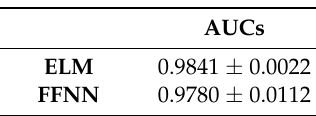
Figure 7. Receiver Operating Characteristic (ROC) curves for extreme learning machines (ELM) and feed-forward neural network (FFNN) models. Table 2. Areas-under-curve (AUCs).